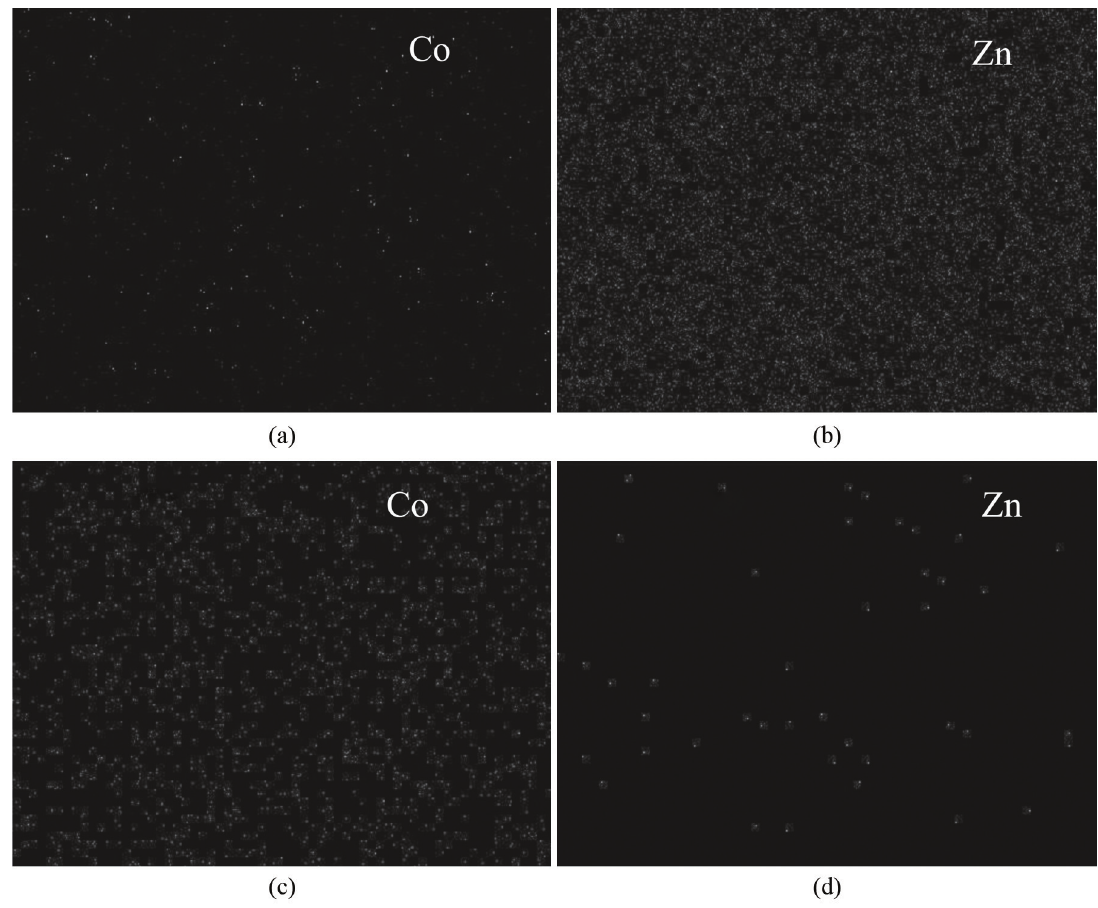
Figure 6. EDS analysis showing the distribution of the elements in the coatings selected from Table 2. Experiment 1: (a) Co and (b) Zn; Experiment 4: (c) Co and (d)